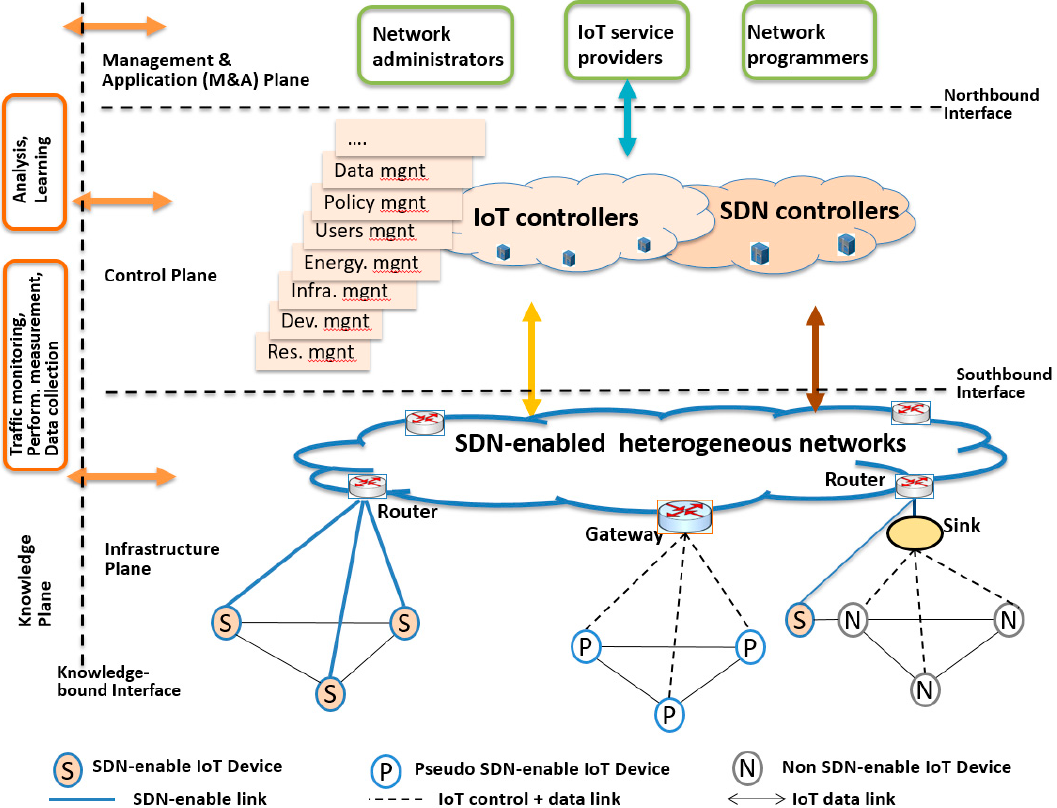
Figure 2. A knowledge-driven SDN-based IoT architecture.